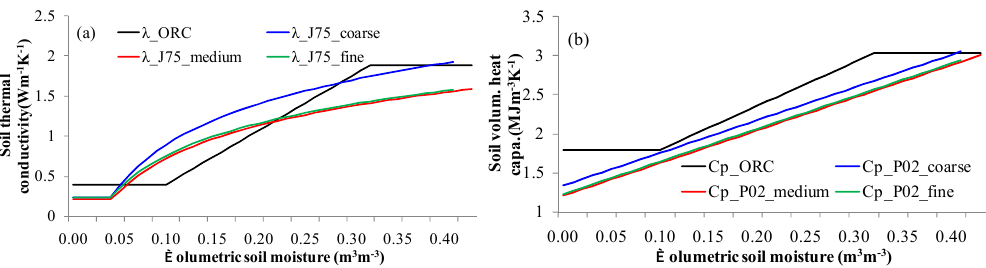
Figure 1. The variation of (a) soil thermal conductivity λ and (b) soil heat capacity C P with volumetric soil moisture for different soil textures (coarse, medium, fine) by using ORCHIDEE standard parameterization (black line) and the revised parameterization ( λ is revised by using J75 method, and C P is revised by using P02 data). The coarse, medium, and fine soil are shown in blue, red, and green lines, respectively. Table 2. The soil thermal property